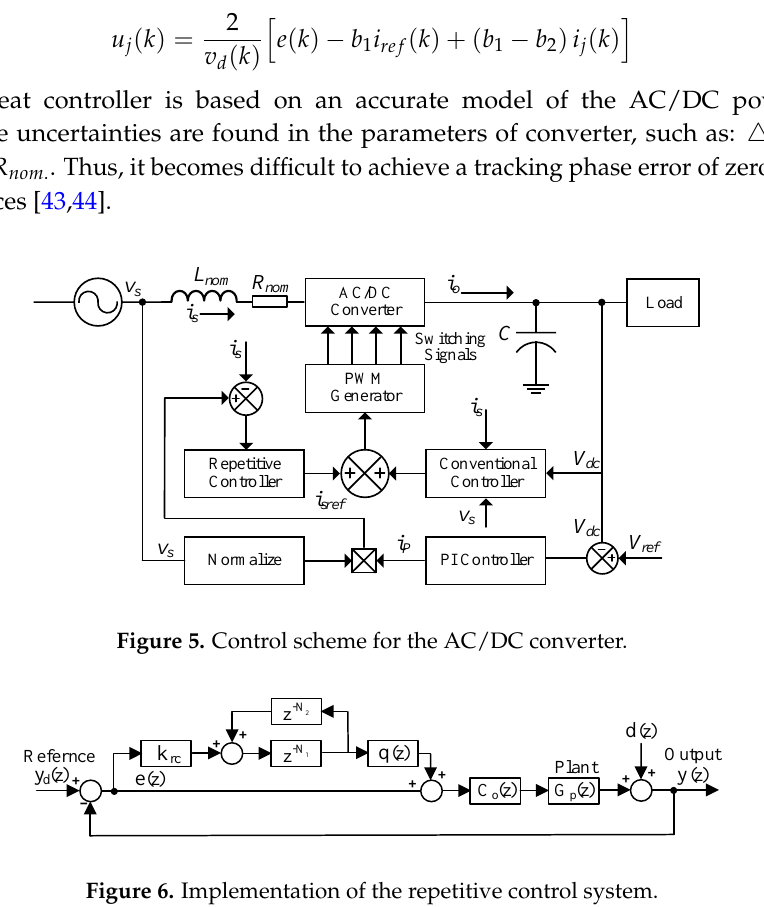
Figure 6. Implementation of the repetitive control system.